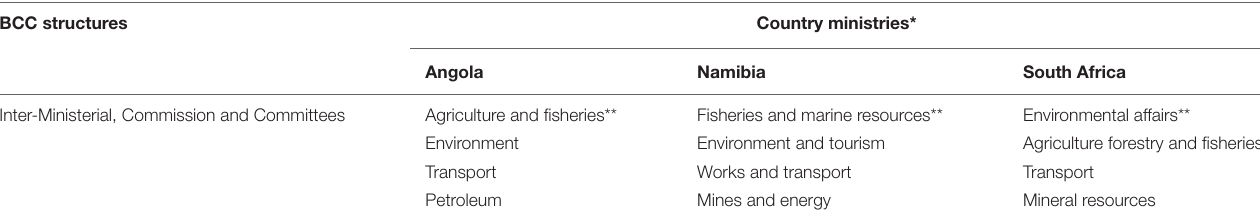
TABLE 1 | BCC party state representation at formal structures of the BCC